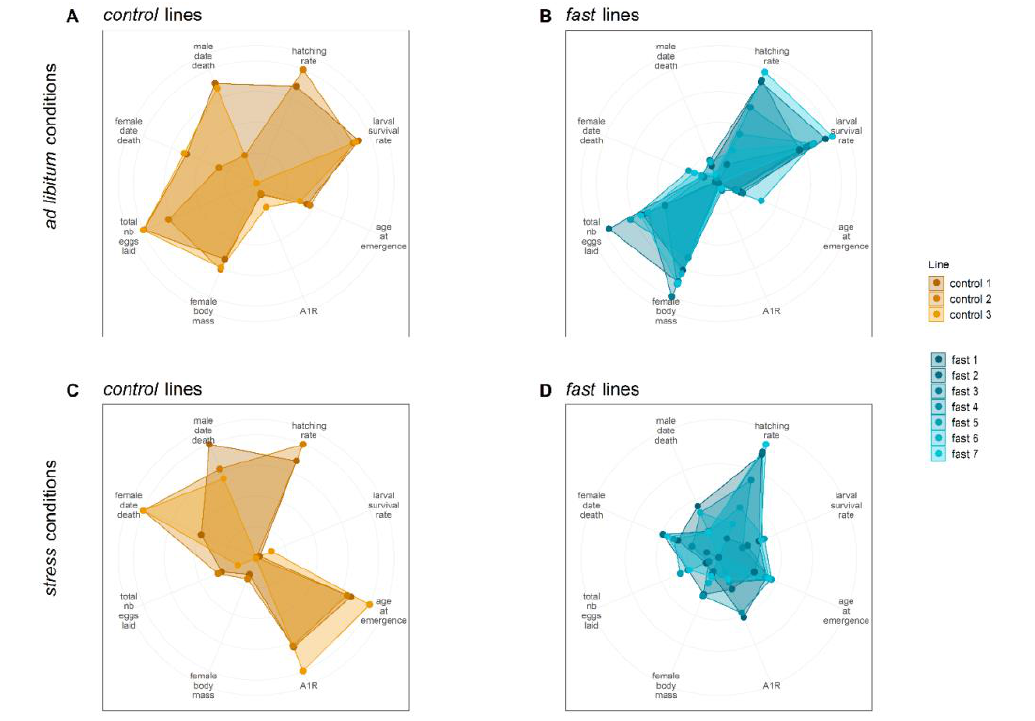
Figure 7: Multi-trait phenotypes of experimental lines of the age at first reproduction selection scheme. Radar plots of G10 control and fast lines phenotyped under ad libitum conditions (A-B, respectively) and stressful conditions (C-D, respectively) for eight traits. Each line displays a distinctive phenotypic response to selection x environment conditions. In contrast to the female body mass selection, selection on age at first reproduction modified most investigated traits. Color code is similar to Figure